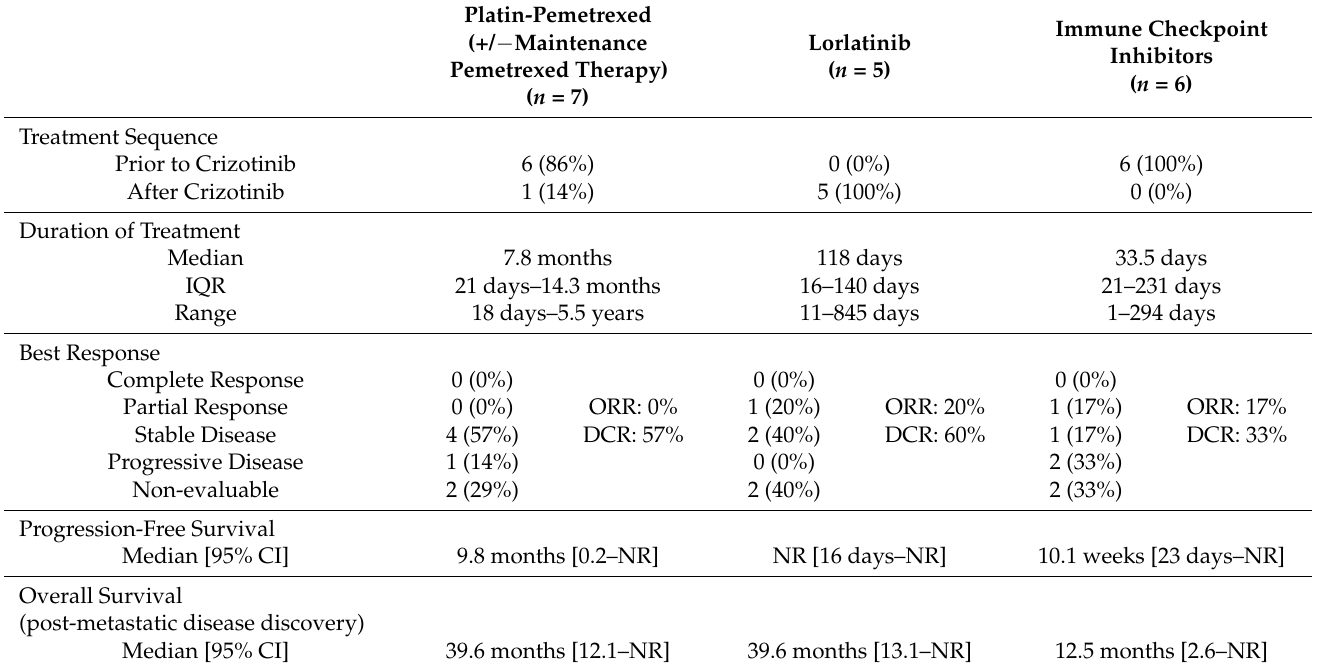
Table 2. Additional non-crizotinib systemic therapies: outcome and effectiveness.